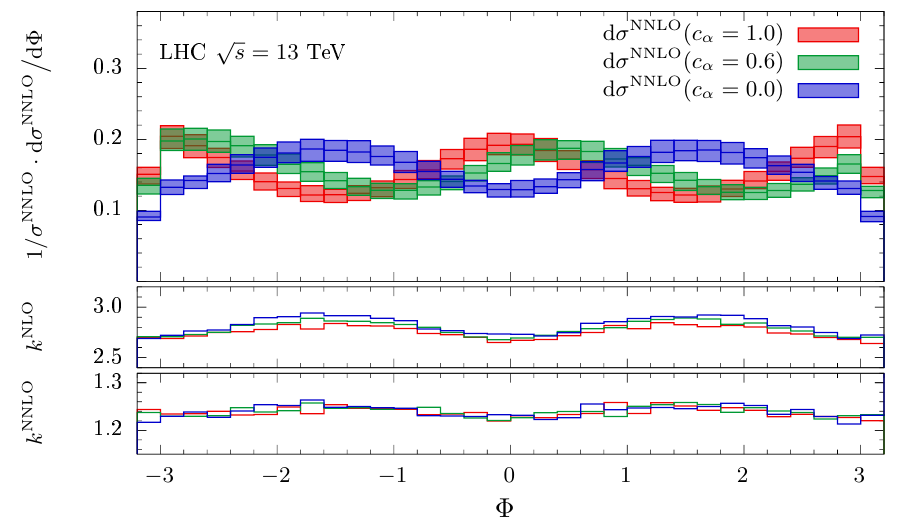
Figure 1 . Normalized distribution at NNLO accuracy and di(cid:11)erential k -factors d k NLO and d k NNLO for the angle (cid:8). See text for further